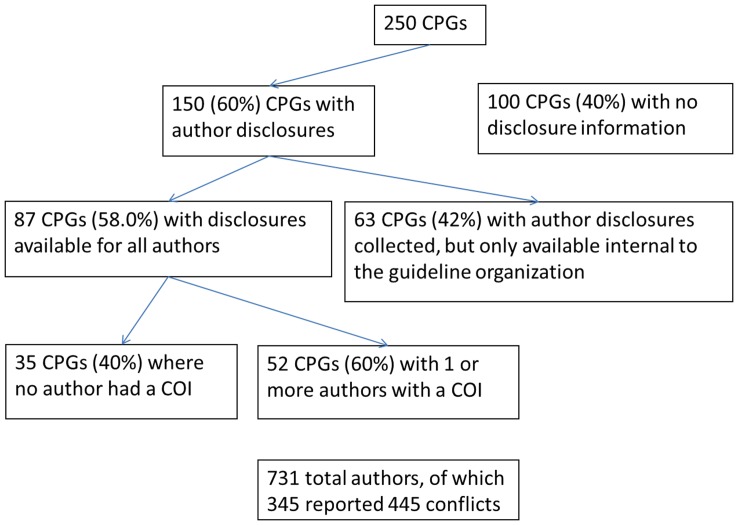
Study flow diagram.Abbreviations: COI, conflict of interest; CPGs, clinical practice guidelines.